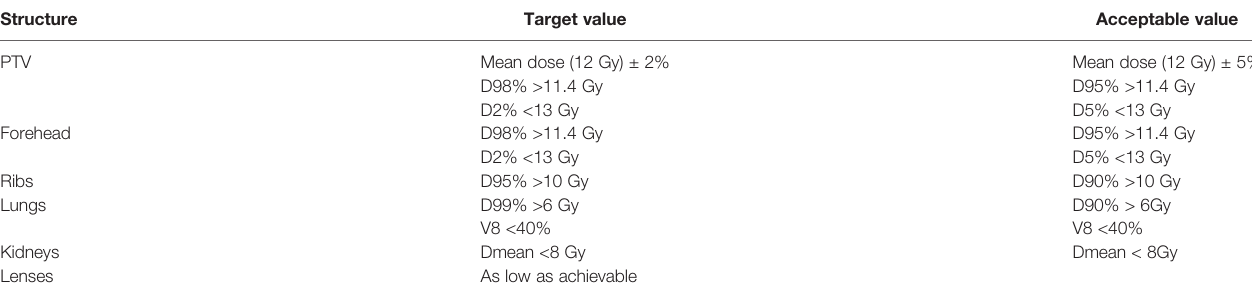
TABLE 2 | Dose prescriptions with “ target ” and “ acceptable ” values.